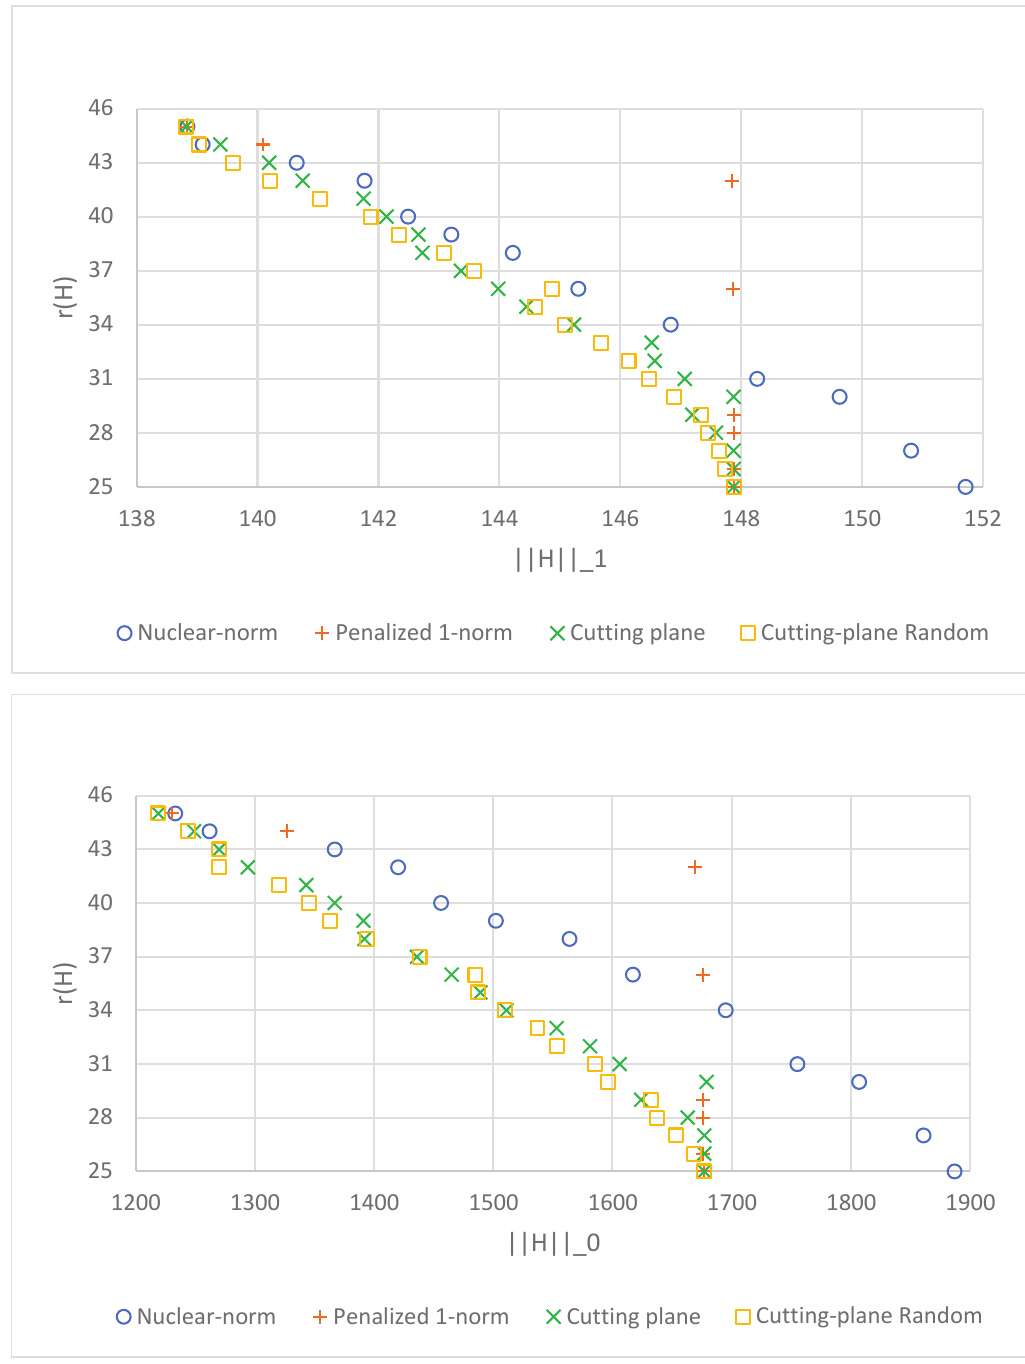
Figure 10 Pareto-curve approximations for an instance: four